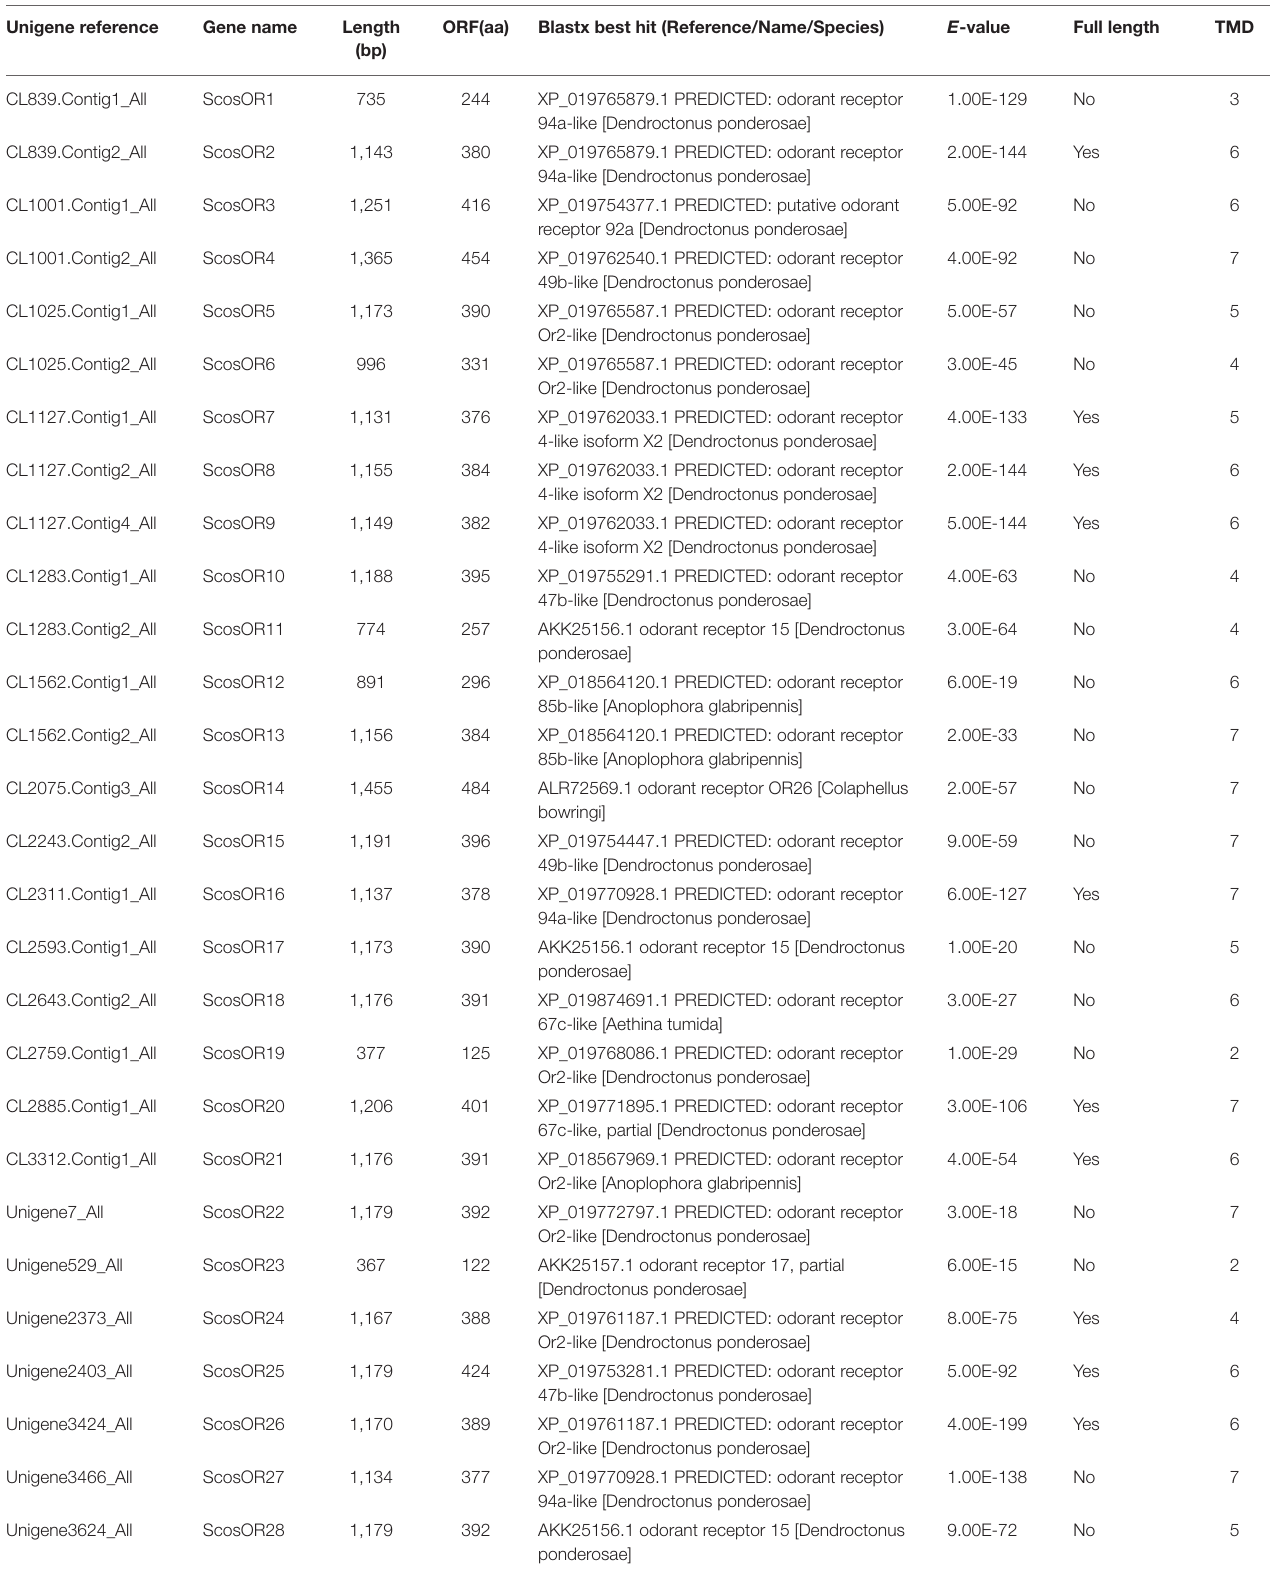
TABLE 1 | Unigenes of candidate odorant receptors. Unigene